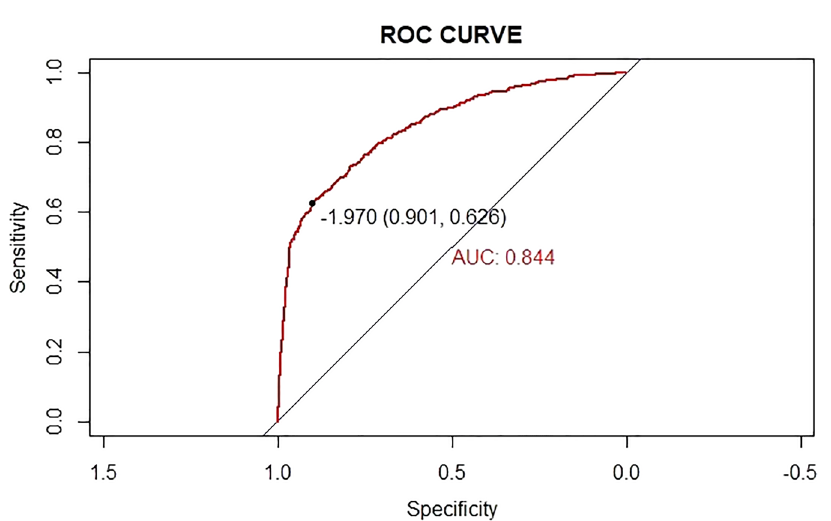
Figure 5. The area under the ROC curve (AUC) value of 0.844 (95% CI: 0.626 to 0.901) indicates that the prediction model has good prediction